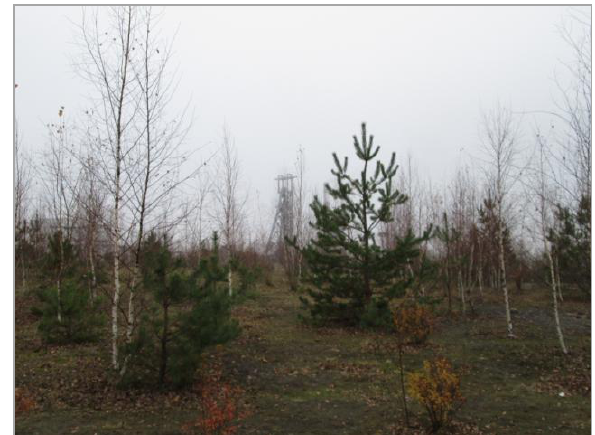
Fig. 7. Processes of rill wash at spoil tip of mine “Murcki-Staszic” in Katowice Kostuchna ( J. Pełka-Gosciniak, November 2014 )